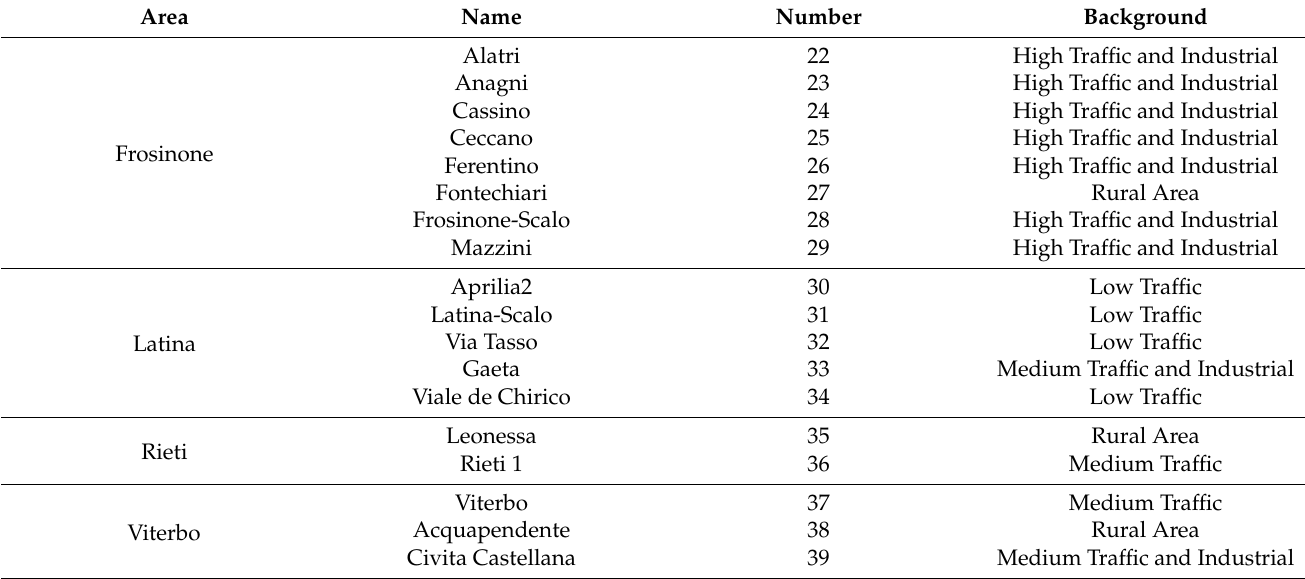
Table 2. Pollutant monitoring stations of the Lazio region province were used in the present study. Area